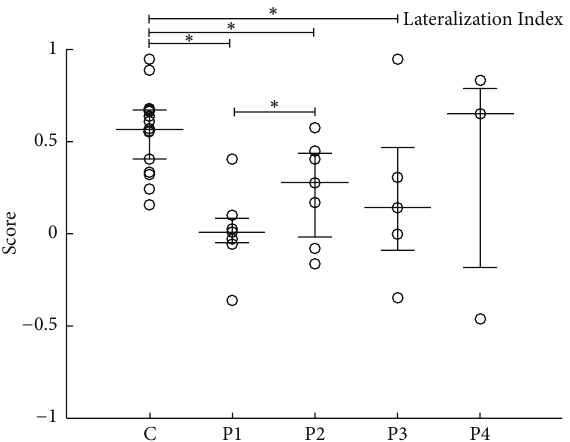
Figure4:LateralizationIndex(LI)ofipsilesionalandcontralesional M1. Values are represented as median and interquartile interval. LI of the control group is presented. For all patients, LI were evaluated at P1, P2, P3, and P4. ∗ 𝑝 < 0.05 ; ∗∗ 𝑝 < 0.01